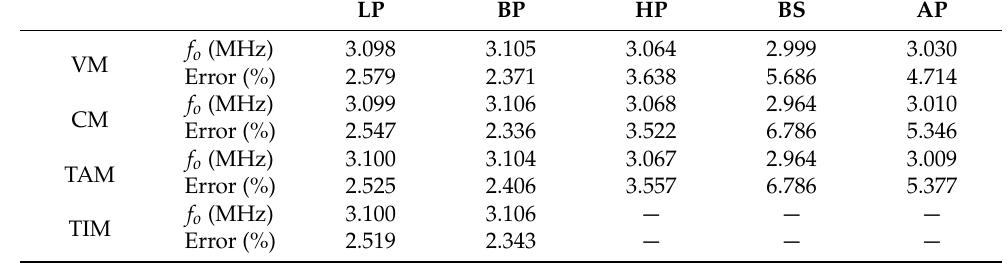
Table 3. Simulated f o and corresponding percentage errors of the proposed mixed-mode universal biquad filter in Figure 3, where theoretical f o = 3.18 MHz.